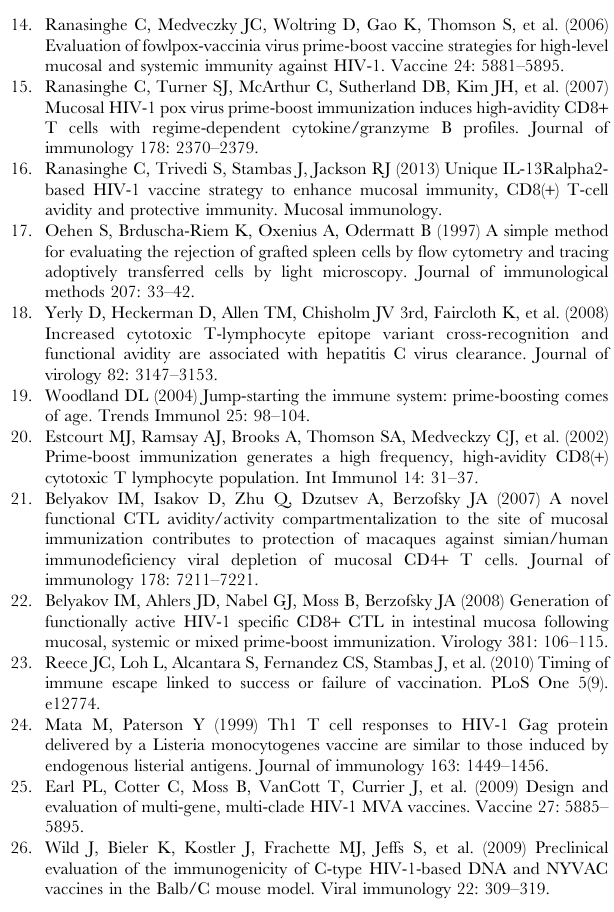
Figure S1 Raw data from screening of HIV-1 pox virus vaccination regimes for high magnitude, high-functional avidity and high epitope variant cross-reactive T cell responses in vivo . Mice were vaccinated with 24 different vaccination regimes as in Figure 3. T cell responses were assessed using a 252-parameter FTAs comprised of fluorescent target